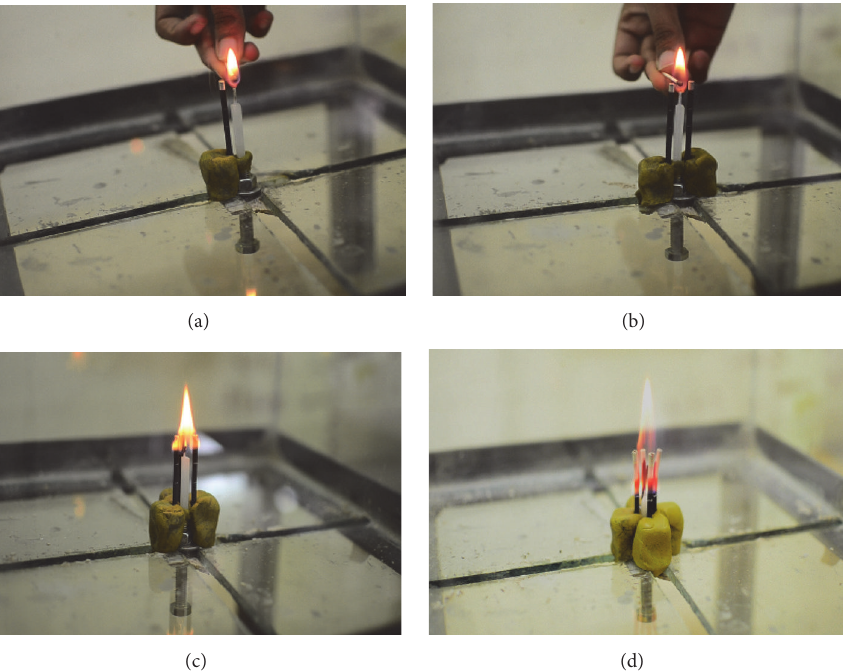
Figure 6: Pictorial view of external heat source (incense sticks) location and number on smoldering combustion at 0.5 cm: (a) single, (b) two, (c) three, and (d) four incense sticks.